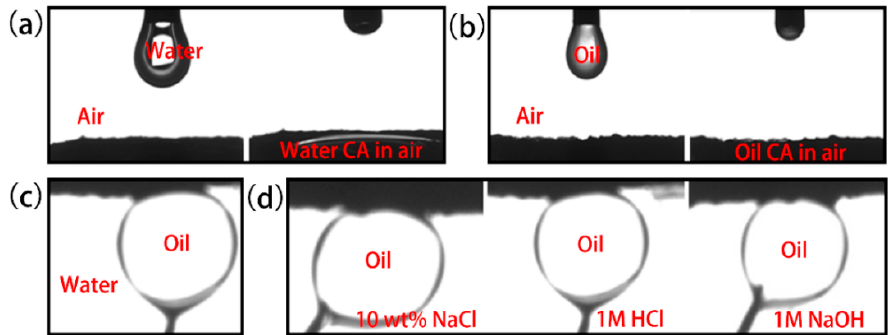
Figure 9. The wetting process of ( a ) a water droplet and ( b ) a toluene droplet on the surface of SPCT in air. ( c ) The toluene contact angle of SPCT in water. ( d ) The contact angle pictures of toluene in aqueous NaCl (10 wt %), HCl (1 mol L − 1 ) and NaOH (1 mol L − 1 ) solutions.